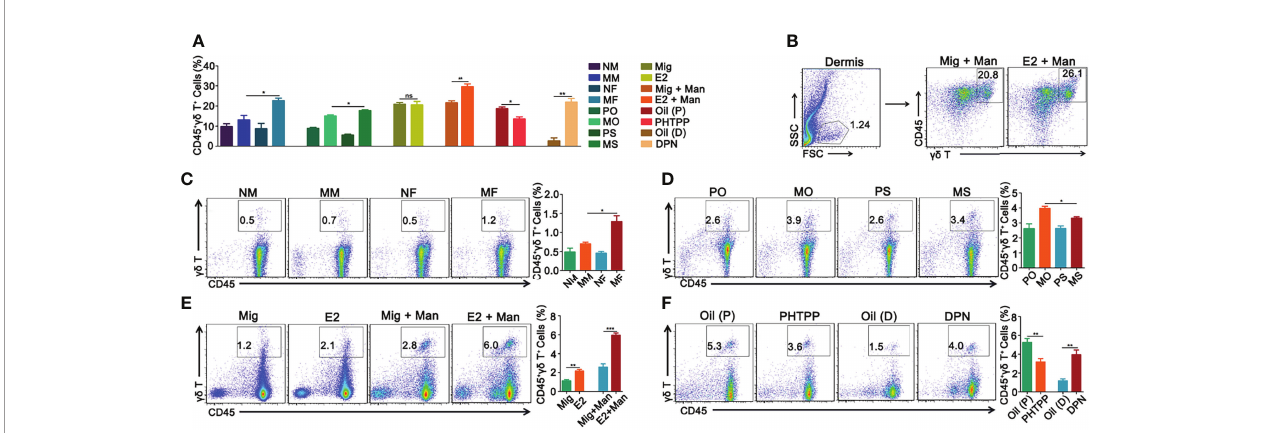
FIGURE 7 | Estrogen enhanced mannan-induced skin in fl ammation was promoted by gd T cells. (A) Percentage of CD45 + gd T + cells in the dermis. (B) Representative pictures of CD45 + gd T + cell expression after 17- b -estradiol treatment in MISI (n = 5/group). (C – F) gd T + cells in the draining lymph nodes from female and male mice, OVX and sham operated mice, 17- b -estradiol, miglyol, PHTPP or DPN treated mice with and without mannan application (n = 5/group). Each experiment was repeated twice. Man, mannan; NM, Naive Male; MM, Man + Male; NF, Naive Female; MF, Man + Female; PO, PBS + OVX; MO, Man + OVX; PS, PBS + Sham; MS, Man + Sham; Mig, miglyol;